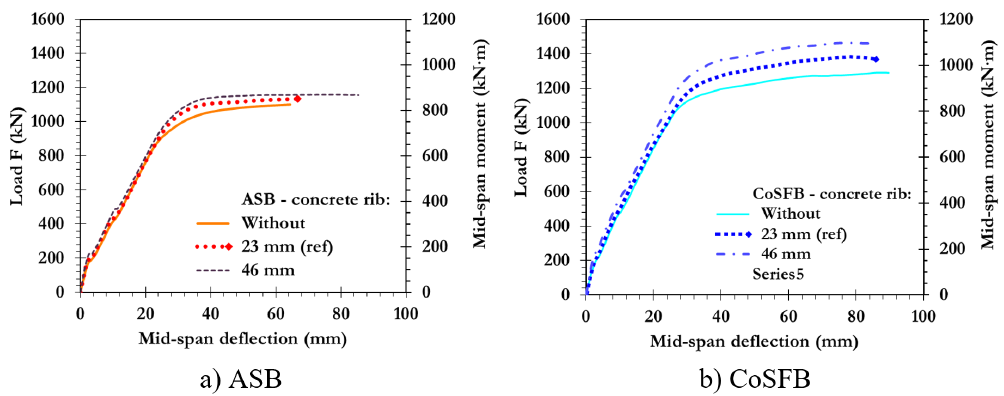
Figure 20. Load-deflection curve – Concrete topping above the steel beam.